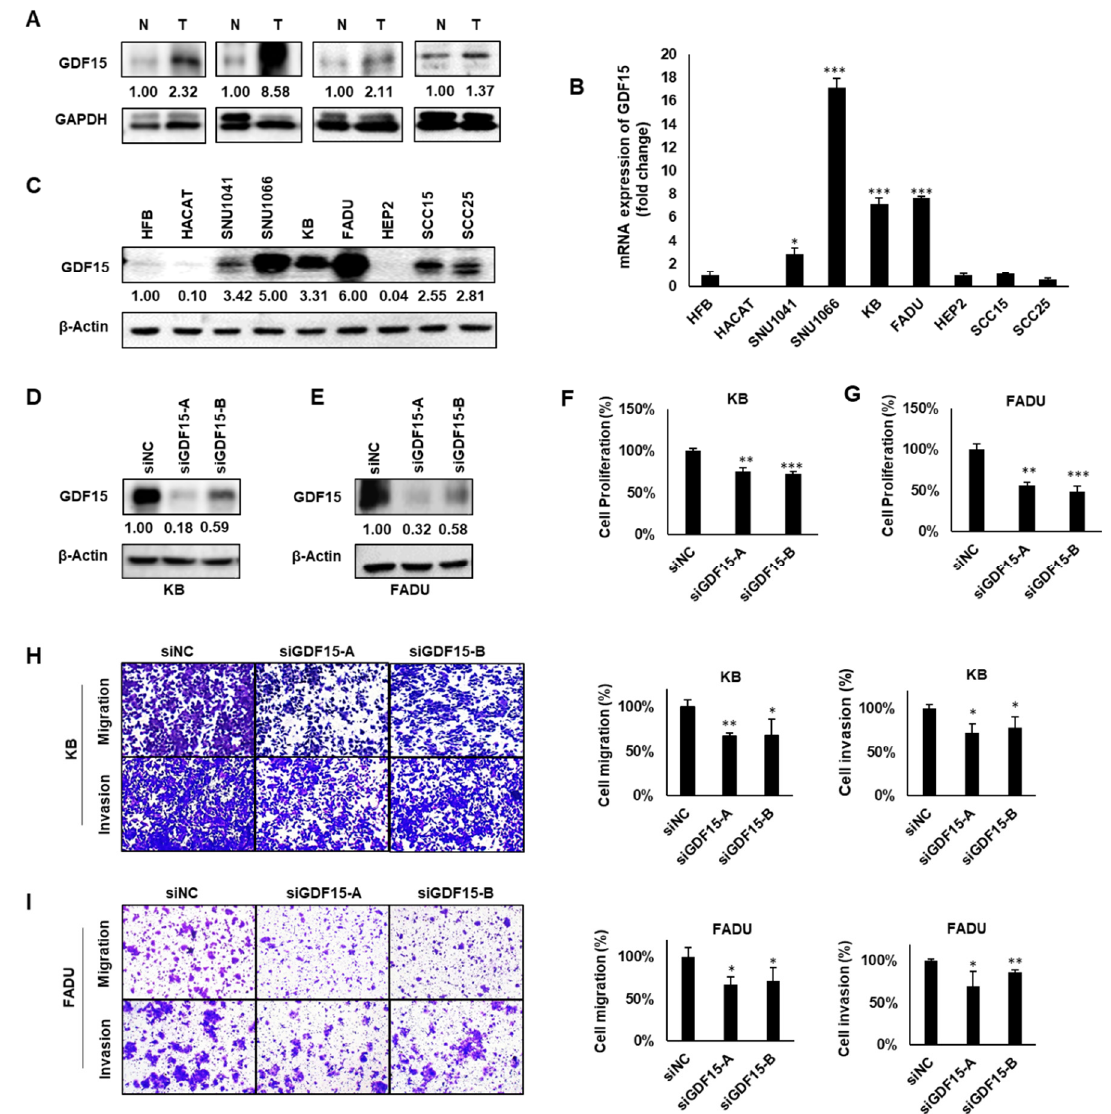
Figure 2. GDF15 expression in HNC. ( A ) Tissue samples obtained from patients with HNC were examined by Western blot analysis using an anti-GDF15 antibody. Representative images of 3 independent experiments are shown. ( B , C ) Two normal head and neck cell lines (HFB, HACAT) and seven HNC cell lines (SNU1041, SNU1066, KB, FADU, HEP2, SCC15 and SCC25) were subjected to RT-PCR analysis and Western blot analysis. Representative images of three independent experiments are shown. ( D – G ) KB and FADU cells were transiently transfected with GDF15-specific siRNAs or siNC (negative control siRNA) for 48 h. Cell viability was analyzed by the WST-1 assay. The levels of GDF15 were detected by Western blot. ( H , I ) After transfection, the cells were allowed to migrate for 24 h in transwell chambers (cell migration) or for 48 h in chambers coated with Matrigel (cell invasion). Magnification, × 40. Differences were considered relevant at p < 0.05 (* p < 0.05, ** p < 0.01, *** p < 0.001). All experiments were repeated at least three times.